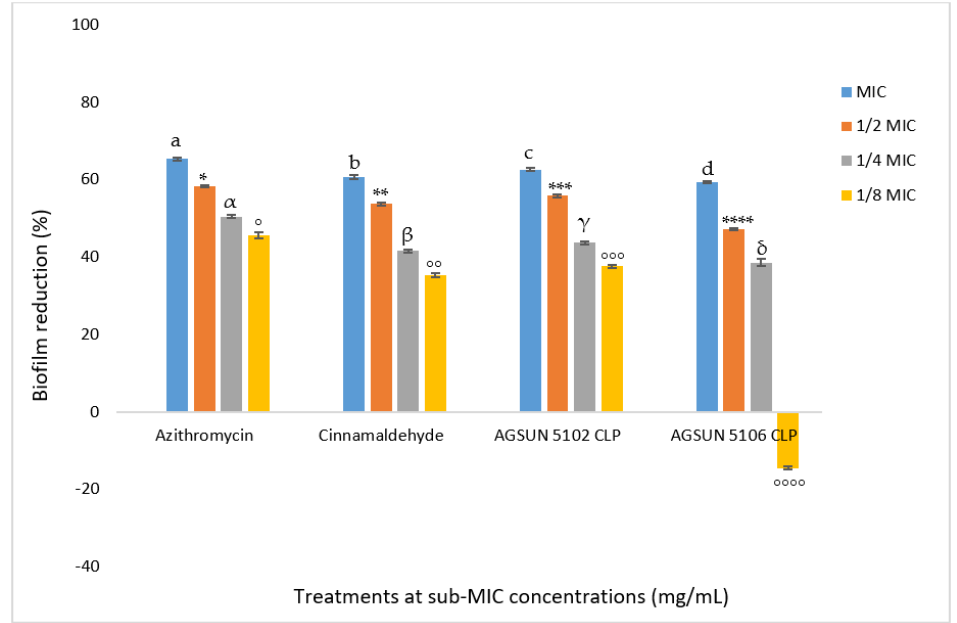
Figure 5. Inhibitory effect of the essential oils on biofilm formation of P. aeruginosa ATCC 27853 at sub-MIC concentrations (mg/mL) of azithromycin at 0.25–0.031 mg/mL (MIC to 1/8 MIC), cinnamal- dehyde at 3.75–0.47 mg/mL (MIC to 1/8 MIC), and both oils (AGSUN 5102 CLP and AGSUN 5106 CLP) at 91.8–11.48 mg/mL (MIC to 1/8 MIC). Letters/symbols represent statistical differences at p - value ≤ 0.05.